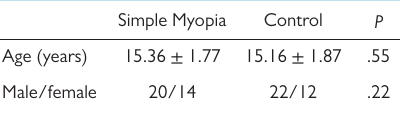
Table 1. Demographic Features of the Study Participants Simple